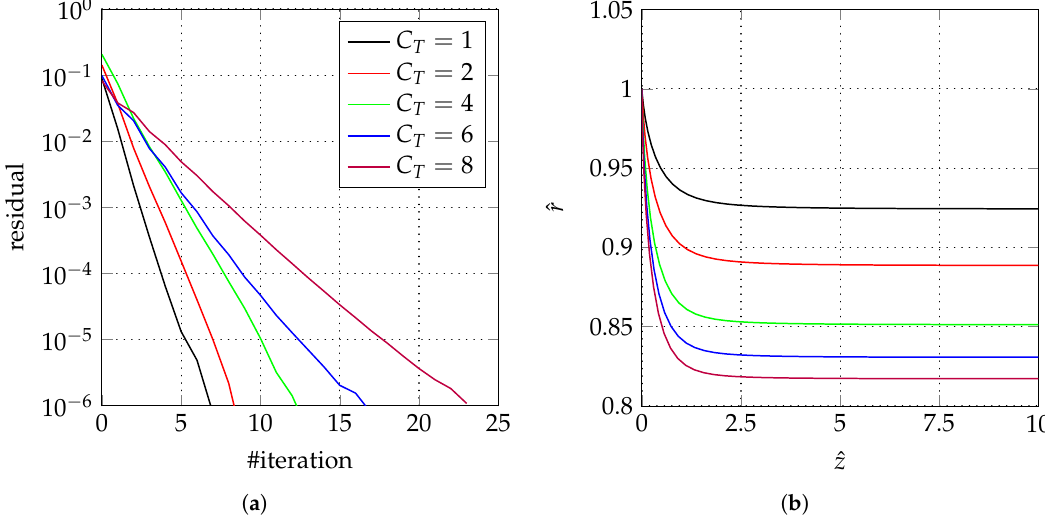
Figure 6. Residual ( a ) and converged wake shape ( b ) for different values of C T .